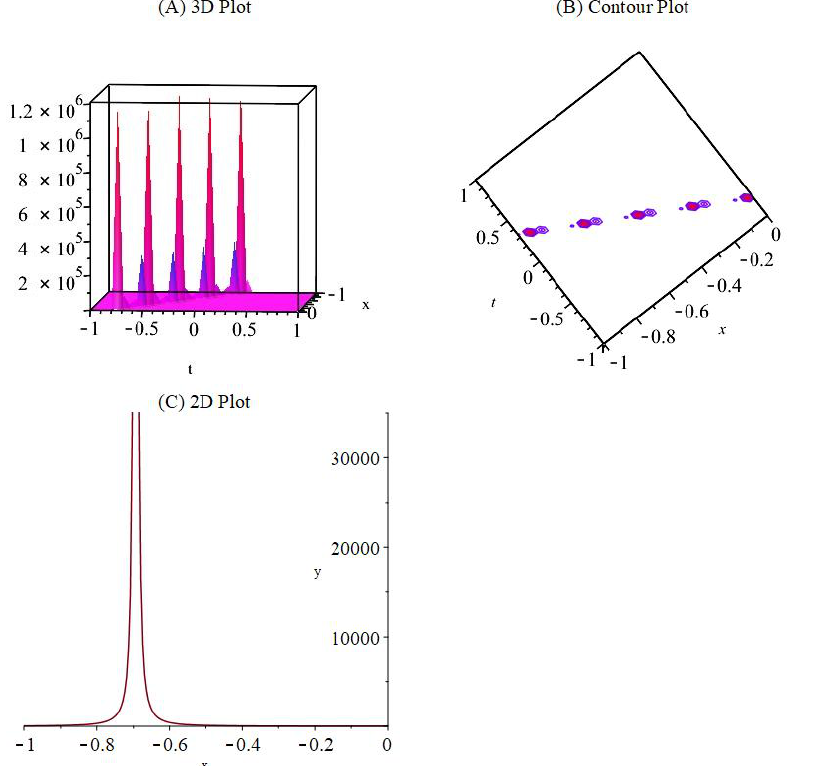
Figure 2. Two-dimensional and three-dimensional plots of the bright soliton solution | Equation ( 11 ) | for ε 1 = − 0.9, ε 2 = 0.5, ε 3 = − 0.2, ε 4 = 0.1, η 1 = 0.5, η 2 = 0.5, Γ = 2, y =